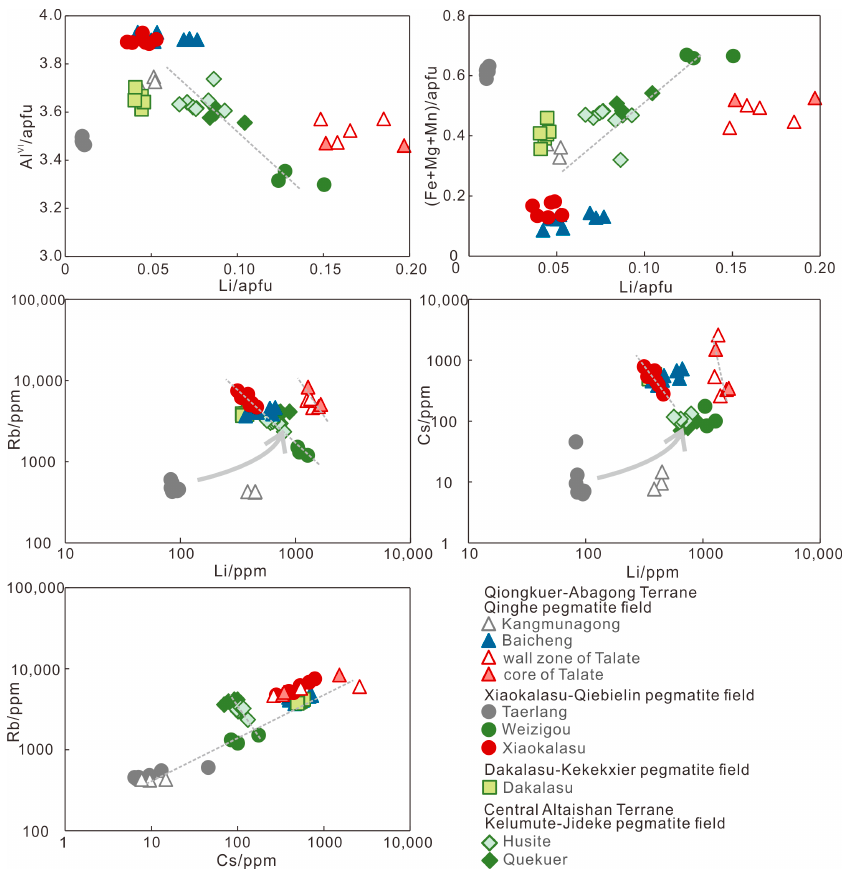
Figure 5. The contents of P and B are basically positively related to evolution degree, but the quartz-muscovite-columbite-tantalite lens of the Baicheng Nb-Ta pegmatite with a middle evolution degree are obviously enriched in P and B (Figure 5), suggesting that fluxes (i.e., B and P) accumulated at late fluid-rich stage during pegmatite evolution compared to other zones of pegmatite.